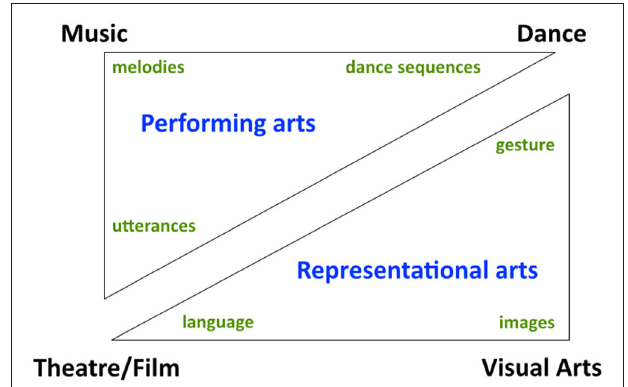
FIGURE 1 | A classification of the arts. The figure shows the four major branches of the arts as making up a tetrad. Within that are opposing triangles. The top triangle is made up of the performing arts. These arts are phrase-based, as comprised of verbal utterances (or sentences in written forms), melodies, or dance sequences. The bottom triangle is made up of the representational arts, which comprise a “narrative triad” of spoken language, gesture, and graphic images. Theater/film and dance sit in both